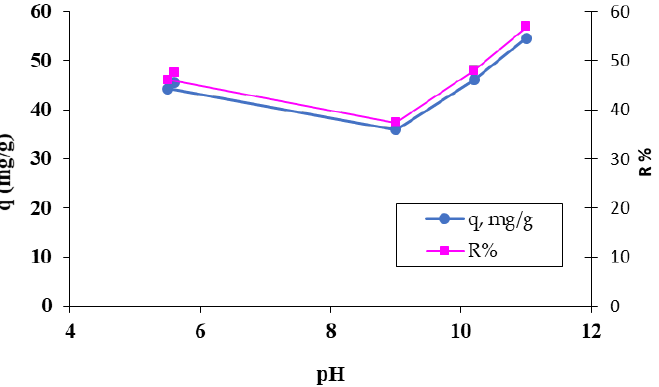
Figure 5. The influence of pH on the retention of the MB cationic dye on the OxC25 hydrogel. Operational conditions: C 0 = 38.4 mg/L; 0.4 g/L biosorbent; T = 20 ◦